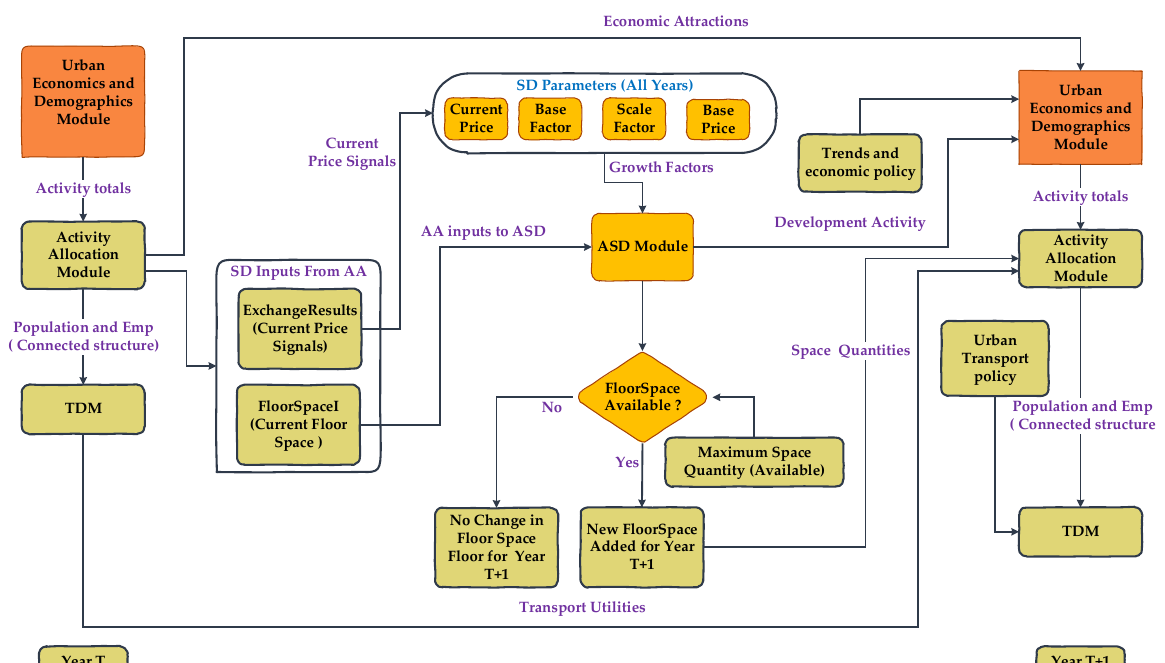
Figure 6. ISE model design diagram.